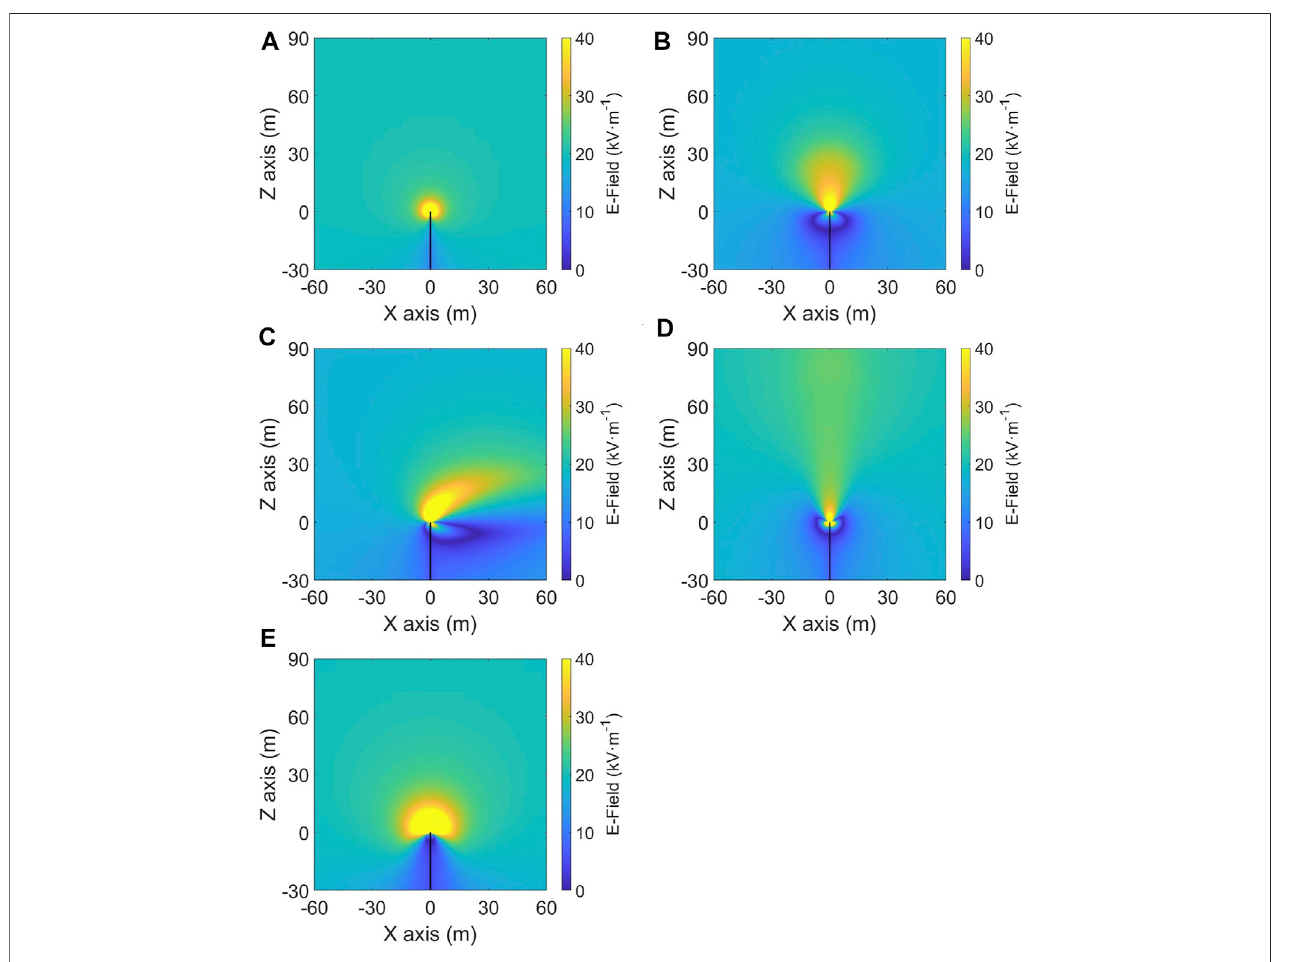
FIGURE 6 | Contours of the vertical component of E- fi eld when the thunderstorm background E- fi eld reached its maximum value (20 kV/m). No corona discharge (A) . No wind (B) . Horizontal wind (C) . Updraft (D) . Downdraft (E) .